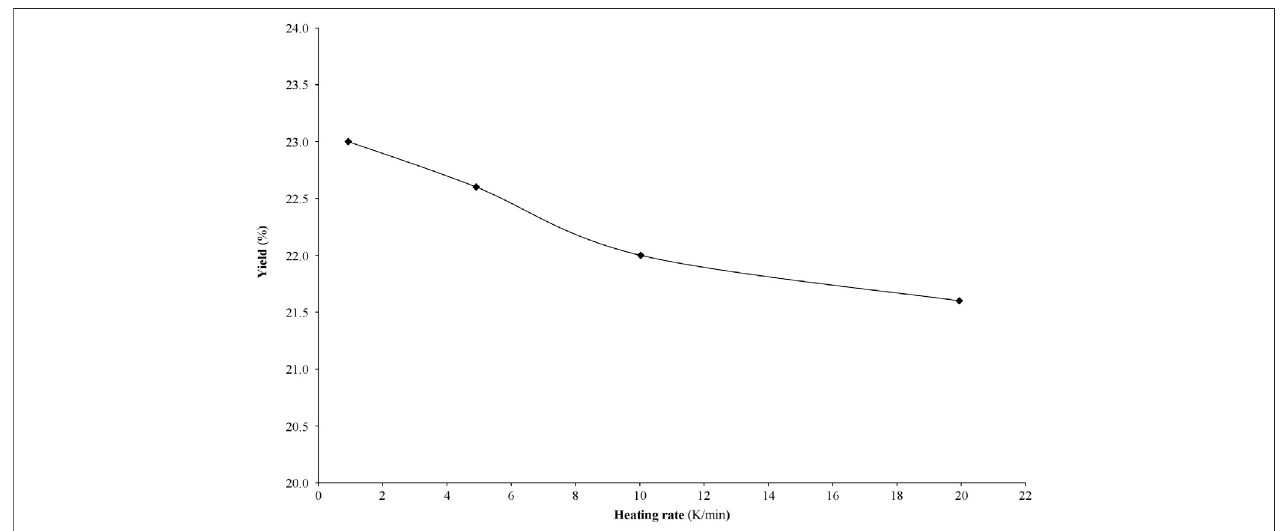
FIGURE 5 | Effect of heating rate to the yield of char from bamboo (N 2 , 1223 K, 300 – 500 μ m, 2 h).